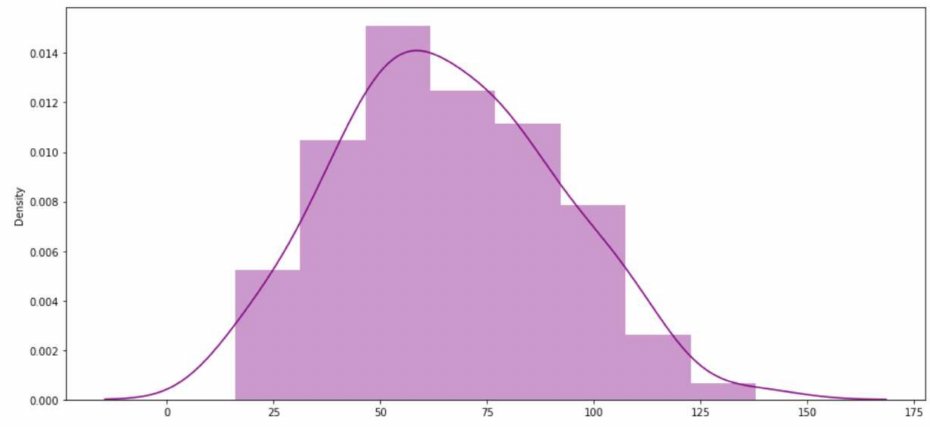
Figure 9. Lengths of Interest